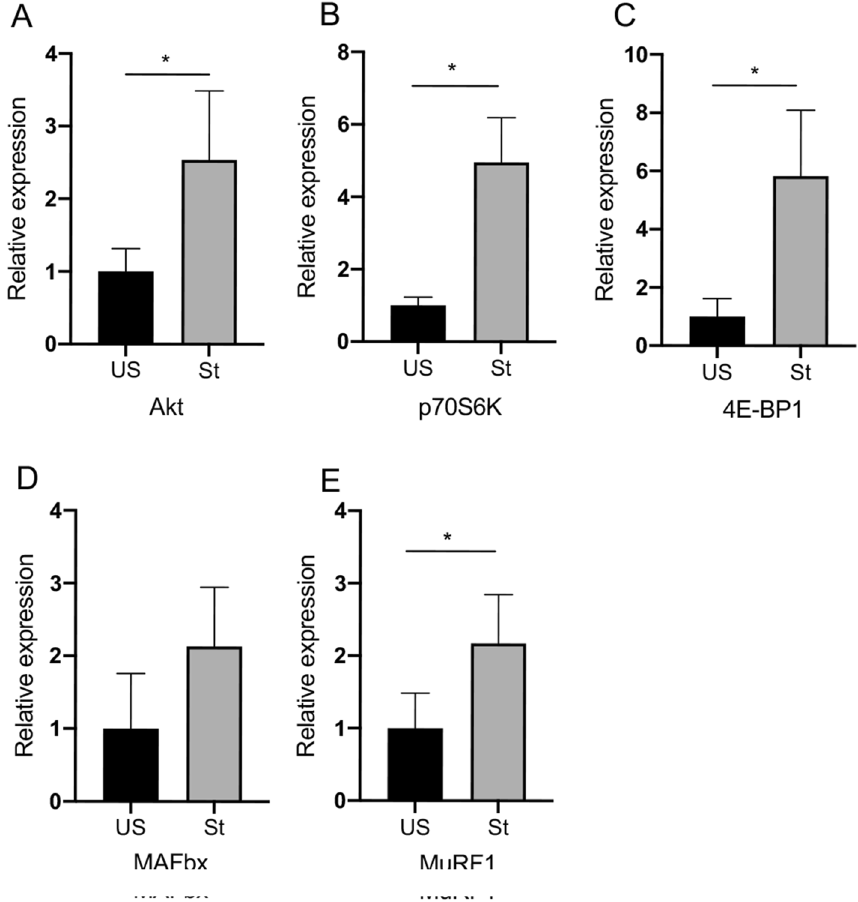
Figure 4. Real-time PCR gene expression of Akt, p70S6K, 4E-BP1, and muscle-specific E3 ubiquitin ligases MAFbx and MuRF1. US unstretched, St stretched. Values are expressed as mean ± SEM. *P < 0.05, n =